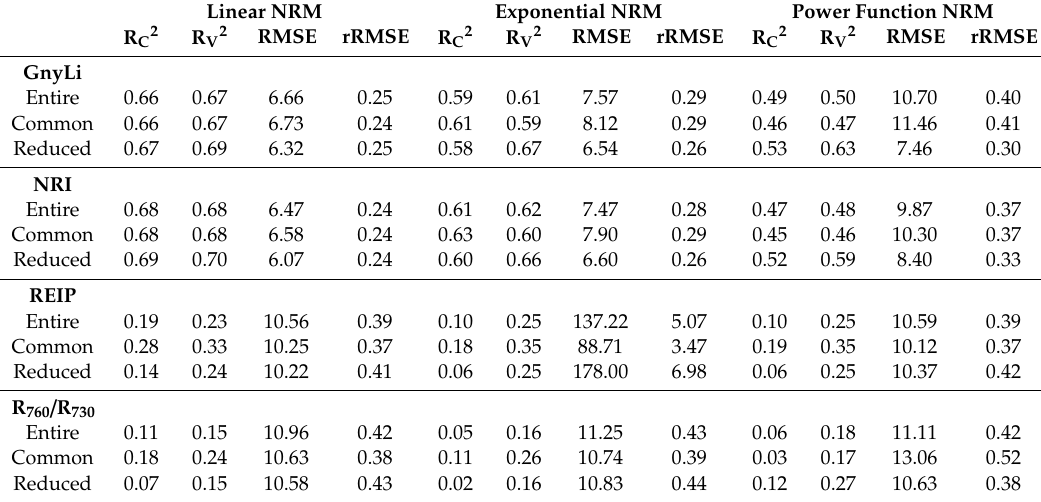
Table 7. Summarized mean values for nitrogen regression models (NRMs) based on vegetation indices (Calibration: R C2 : coe ffi cient of determination; Validation: R V2 : coe ffi cient of determination, RMSE: root mean square error (g / kg), rRMSE: relative root mean square error; Entire: entire data set; Common: common N fertilization; Reduced: reduced N fertilization). The statistics for each possible subset combination are shown in the appendix (Table